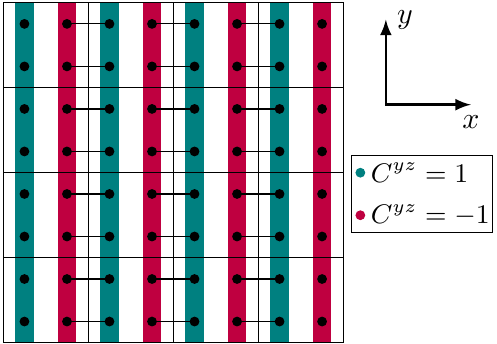
Figure 11: The model in Eq. (84) can be viewed as the stacking of Chern super- conducting layers with SSH like coupling between the layers. In the fully dimerized limit, it is clear that the bulk of the system is Wannier representable, whereas the surfaces perpendicular to the x -direction are